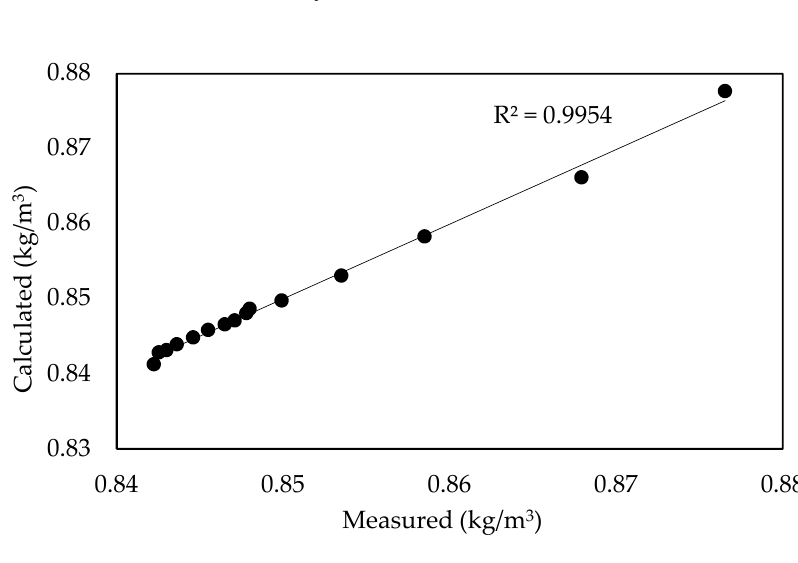
Figure 8. Parity plot for fuel density.